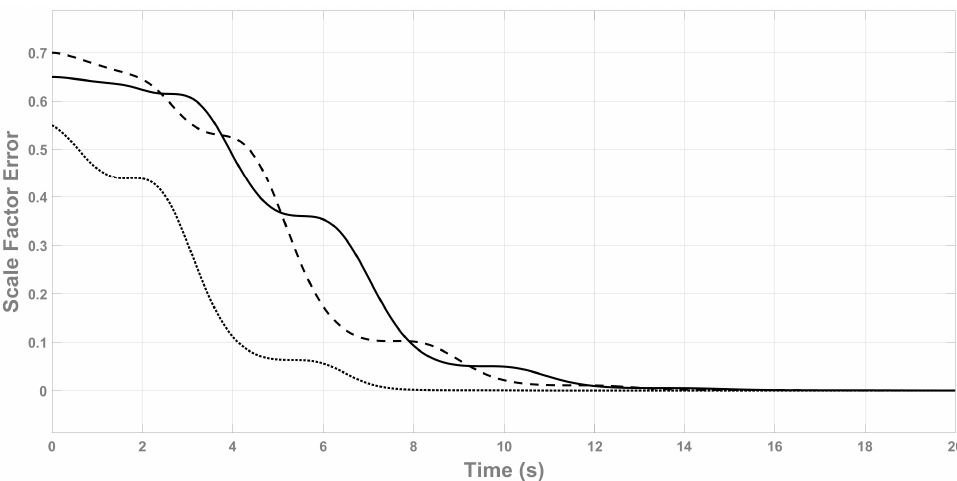
Figure 3. Scale factor estimator error ˜ K . ˜ k x (continuous line), ˜ k y (dashed line), ˜ k z (dotted